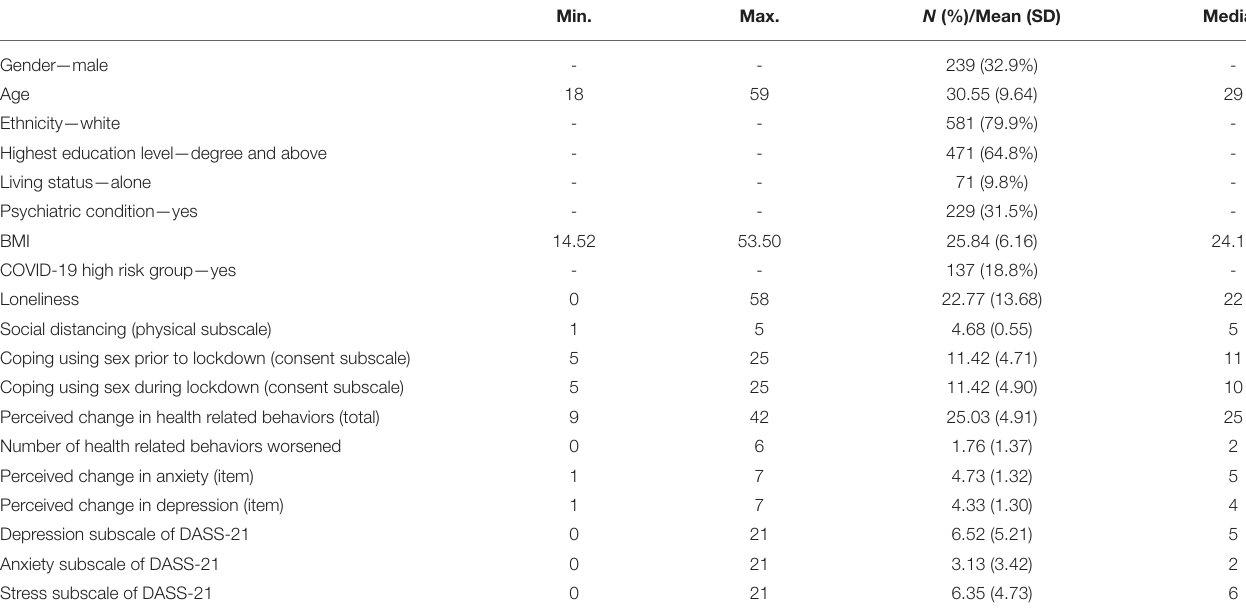
TABLE 1 | Descriptive statistics ( N = 727).